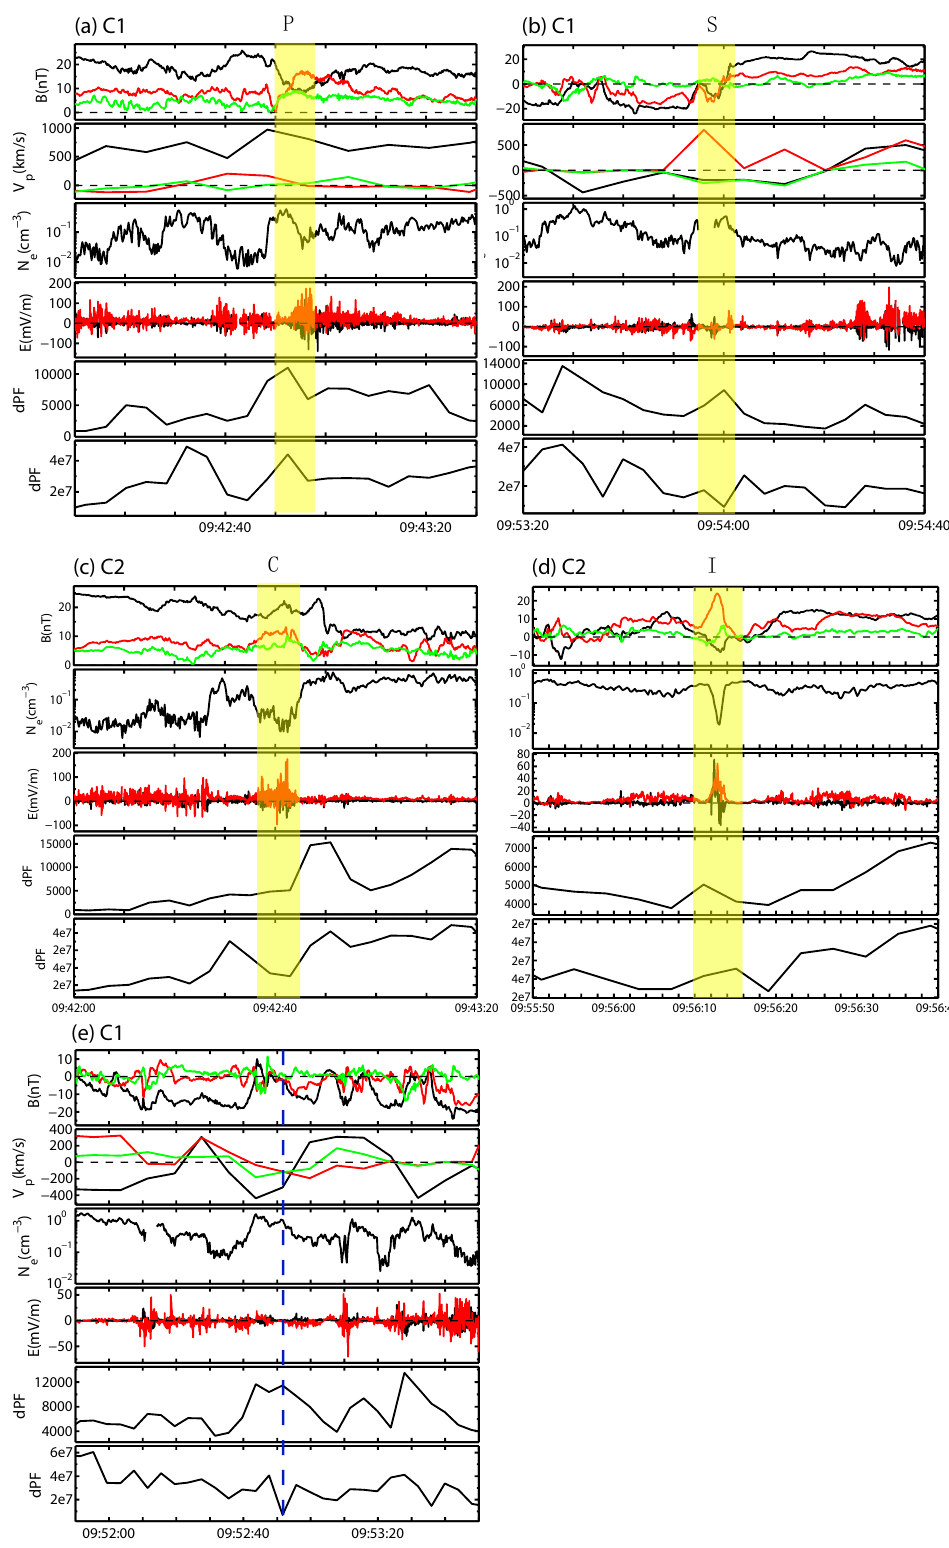
Figure 4. Observations of four structures on 22 August 2001 event: (a) flux pileup region by C1, (b) thin current sheet by C1, (c) density cavity by C2, (d) magnetic island by C2 and (e) the maximum flux ratio recorded in this event. The vertical dashed line in (e) marks the time when the maximum flux ratio was detected by C1. The format of (a–e) is the same as Fig. 3 except in (c) and (d) that plasma flow data are